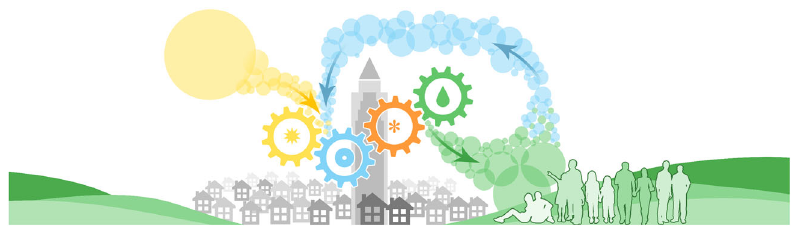
Fig. 1 The vision of crowd oil. Renewable oil wells, a distributed social technology, whereby people in homes, of fi ces and commercial buildings all around the world, collectively harvest renewable electricity and heat and use air conditioning and ventilation systems to capture CO 2 and H 2 O from ambient air and convert it, by chemical processes, into renewable synthetic oil — crowd oil — substituting for non-renewable fossil-based oil — a step towards a circular CO 2 economy for the bene fi t of